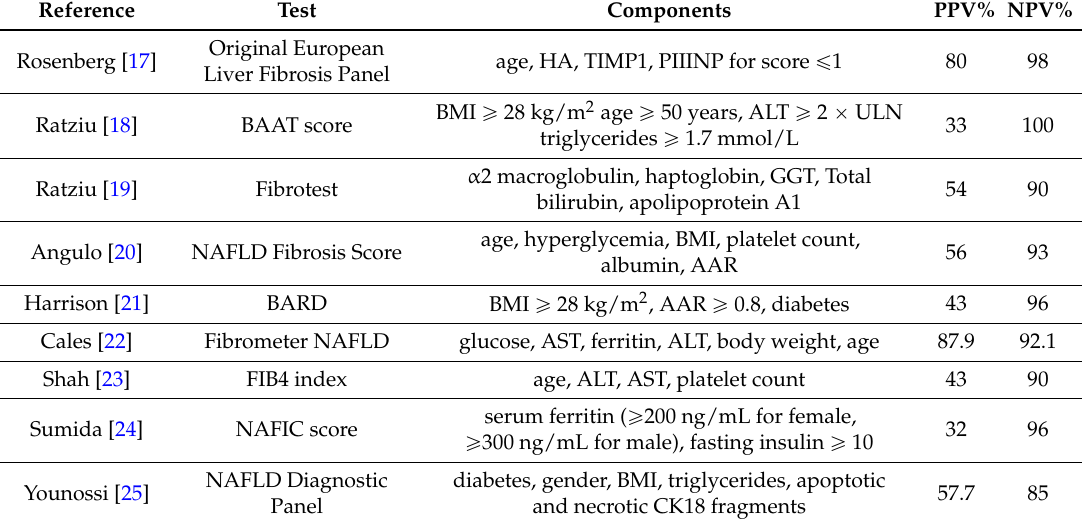
Table 1. Non-alcoholic fatty liver disease (NAFLD) prognostic panels for